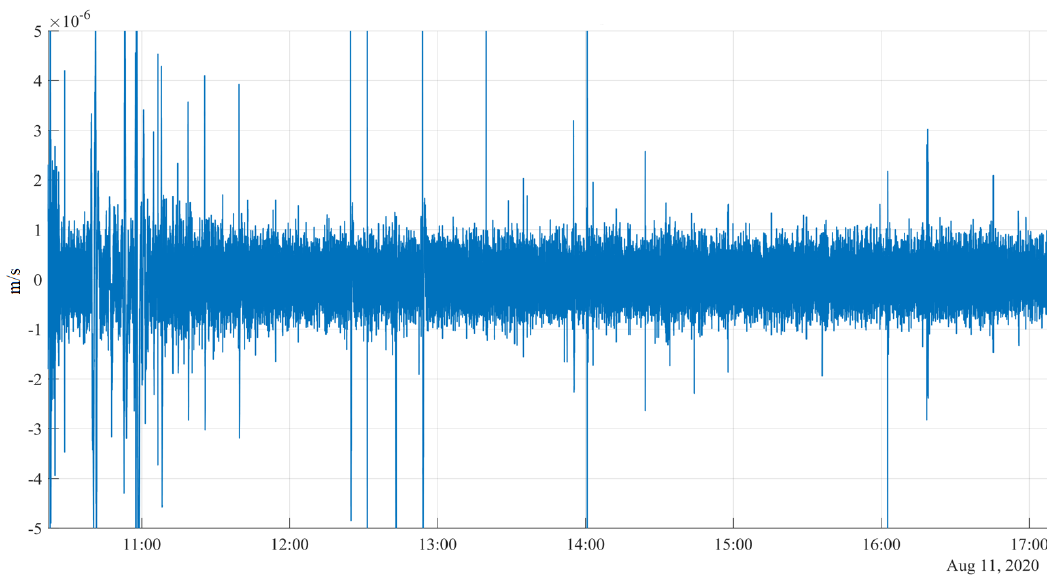
Figure 9. The seismogram recorded on near the crater edge on the Avachinsky volcano.